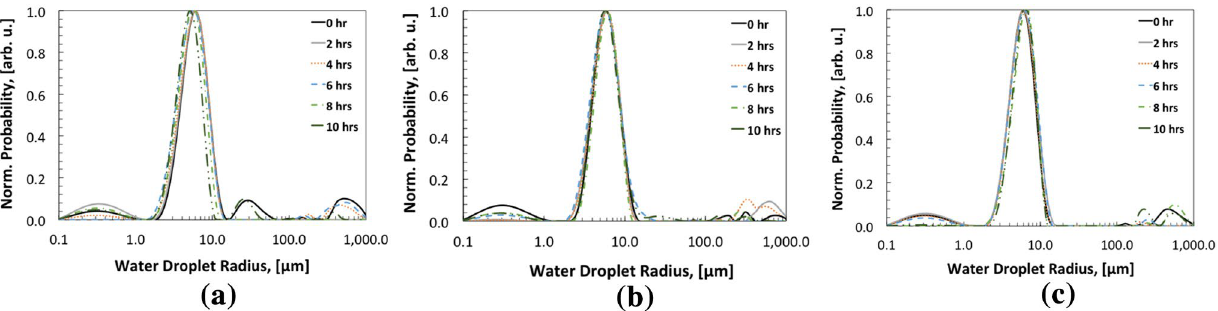
Fig. 7 Droplet size distributions for: a top, b middle and c bot- tom physical locations of the reference (blank) water-in-oil emul- sion obtained from the PFG NMR diffusion experiments. This blank sample is used as a reference. No significant shift for the middle and